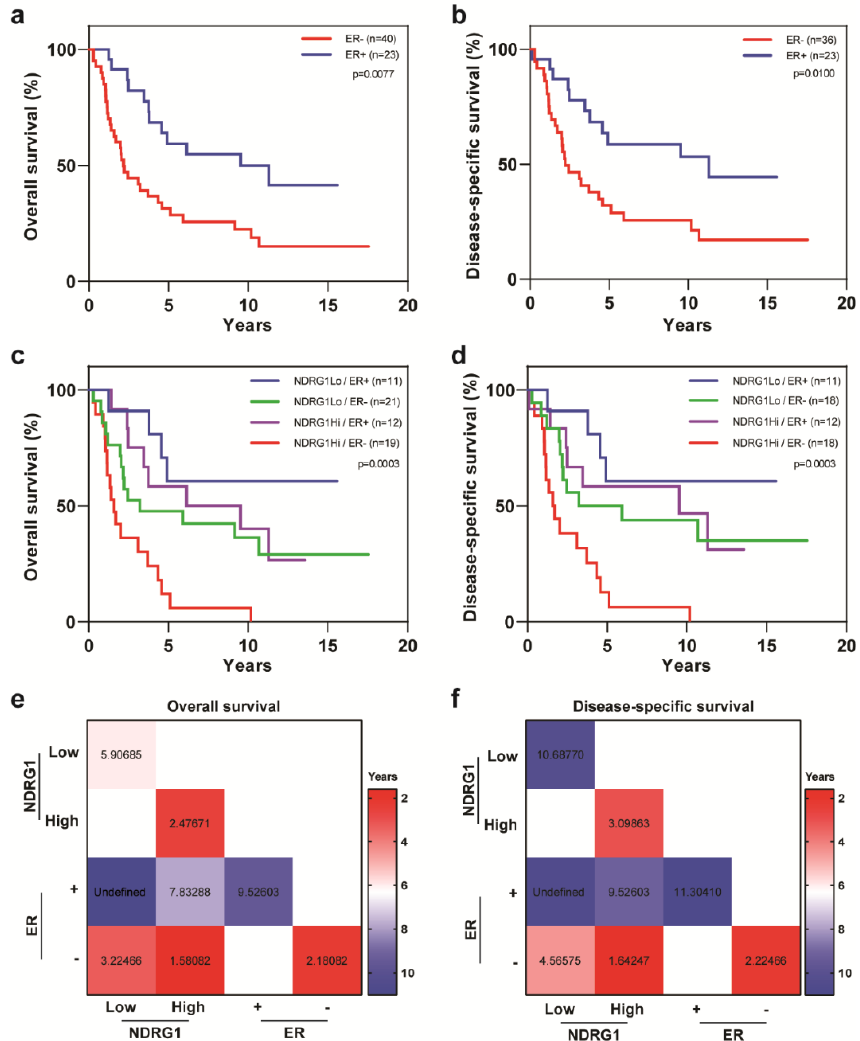
Figure 3. Overall survival and disease-specific survival in patients with IBC stratified by estrogen receptor (ER) status and NDRG1 expression. Patients with ER-negative tumors had ( a ) worse overall survival and ( b ) worse disease-specific survival versus patients with ER-positive tumors. ( c , d ) Stratification of patients by ER and NDRG1 expression status in terms of overall survival and disease-specific survival. Log-rank tests were used to obtain p values. ( e , f ) Median overall survival and disease-specific survival times, in years, for patients stratified by ER status and NDRG1 expression. Disease stage was another independent prognostic variable for OS (HR = 4.35, 95% CI = 1.685–